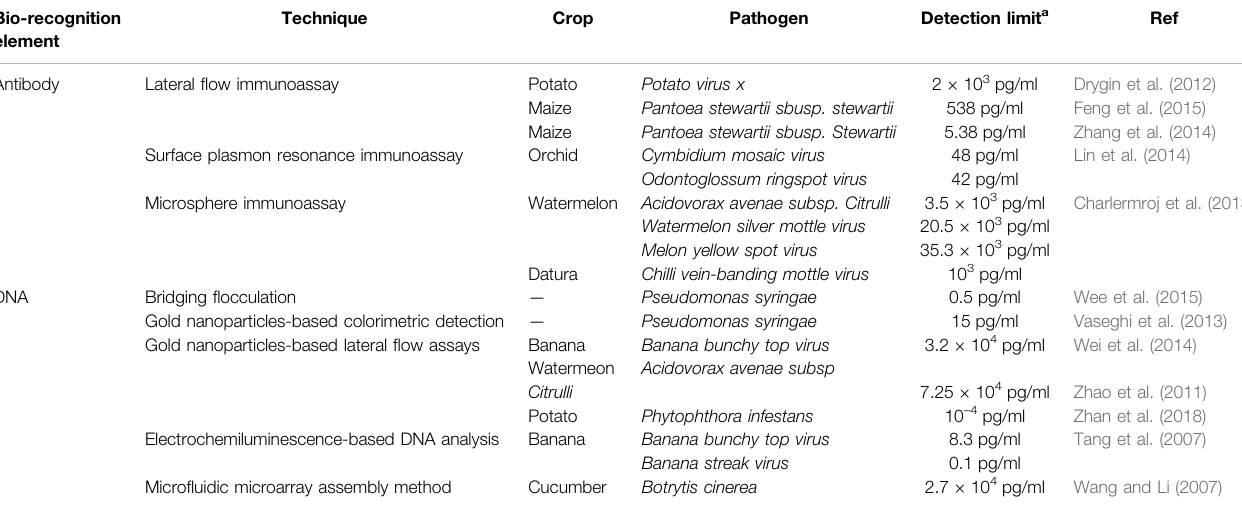
TABLE 2 | Examples of optical biosensors developed for the detection of plant pathogens. Bio-recognition